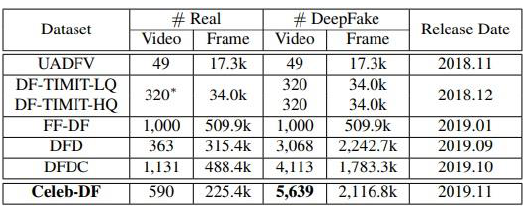
Table 2. Basic details of the version dataset based on